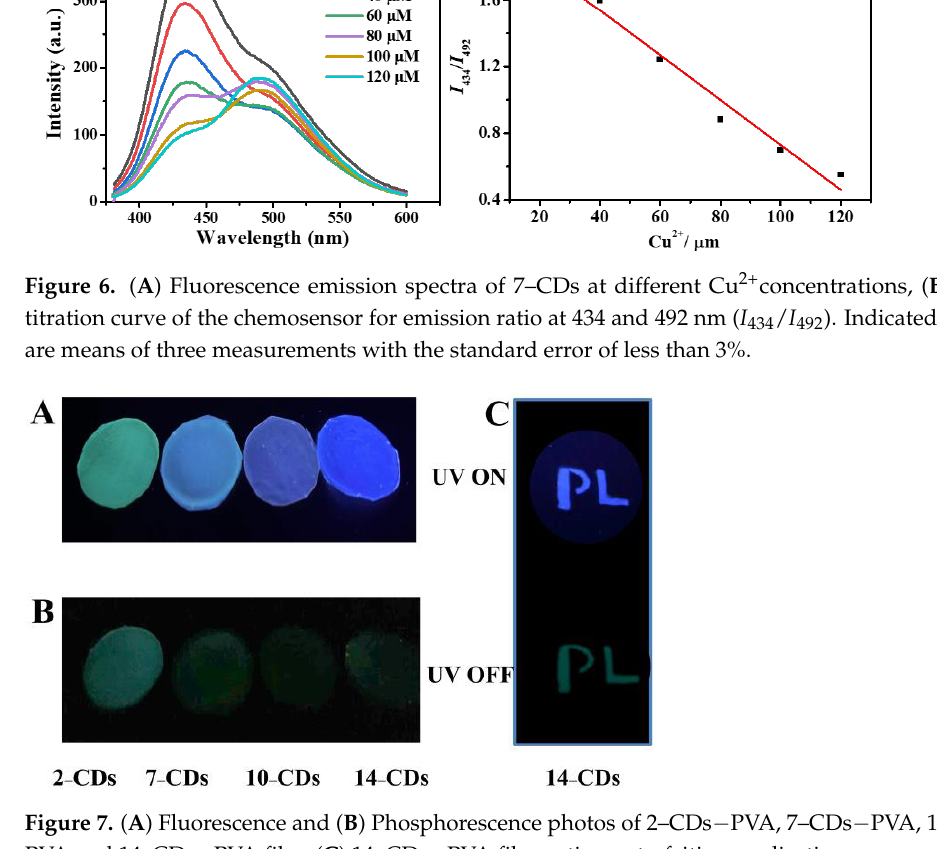
Figure 6. ( A ) Fluorescence emission spectra of 7 − CDs at different Cu 2+ concentrations, ( B ) Cu 2+ titra- tion curve of the chemosensor for emission ratio at 434 and 492 nm ( I 434 / I 492 ). Indicated values are means of three measurements with the standard error of less than 3%.